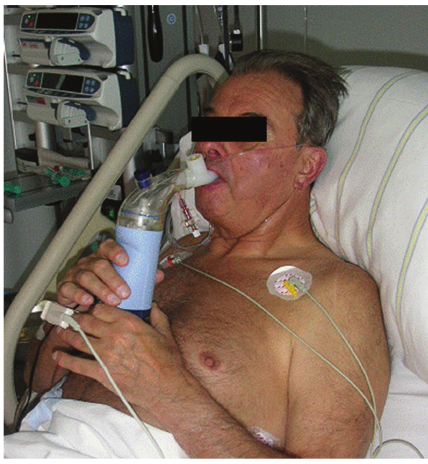
Figure 6: Preoperative inhalation of iloprost in spontaneous